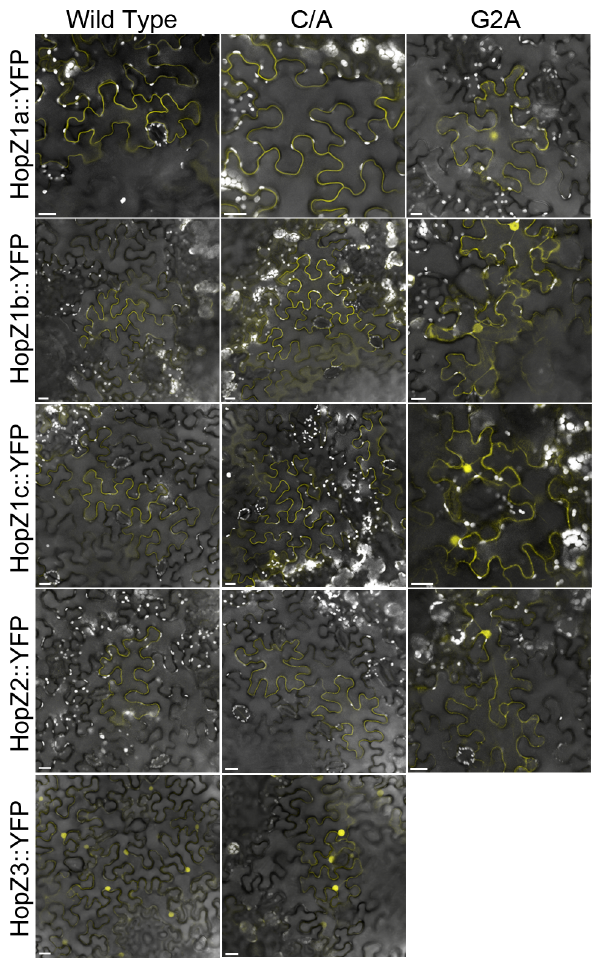
Fig. 6. HopZ1a, HopZ1b, HopZ1c and HopZ2 localize to the vicinity of the plasma membrane while HopZ3 is primarily nuclear localized. Agrobacterium tumefaciens carrying HopZ-YFP constructs was pressure-infiltrated into Nicotiana benthamiana leaves, and expression was induced by spraying leaves with 30 m M dexamethasone 24 hours post-infiltration. Leaves were imaged 24–48 hours after dexamethasone induction. C/A indicates the catalytic cysteine was mutated to an alanine. G2A indicates the myristoylated glycine was mutated to an alanine.